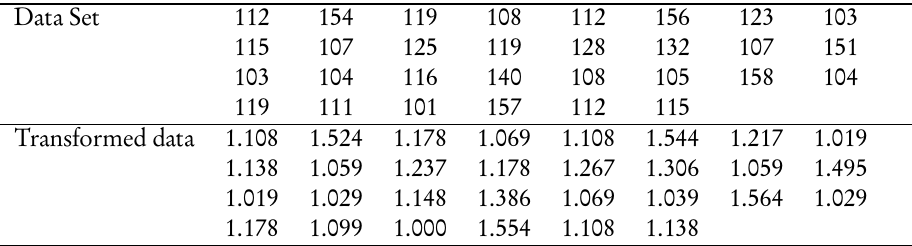
The annual wage data.